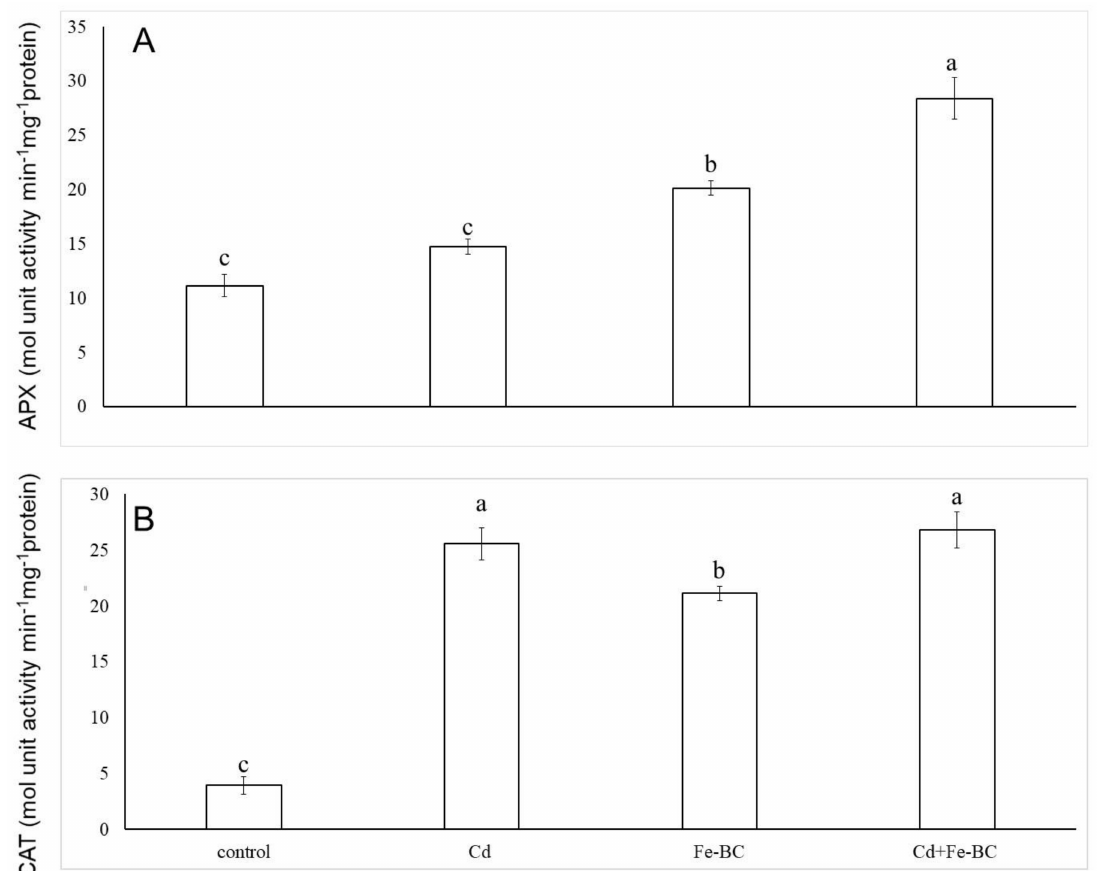
Figure 2. Ascorbate peroxidase (APX) ( A ) and catalase (CAT) ( B ) activities (mol unit activity min − 1 mg − 1 protein) of radish leaves grown under various treatments (control, Cd, Fe-BC, Cd+Fe-BC). There were three repeats/treatment. Values are the average of three replicates ±